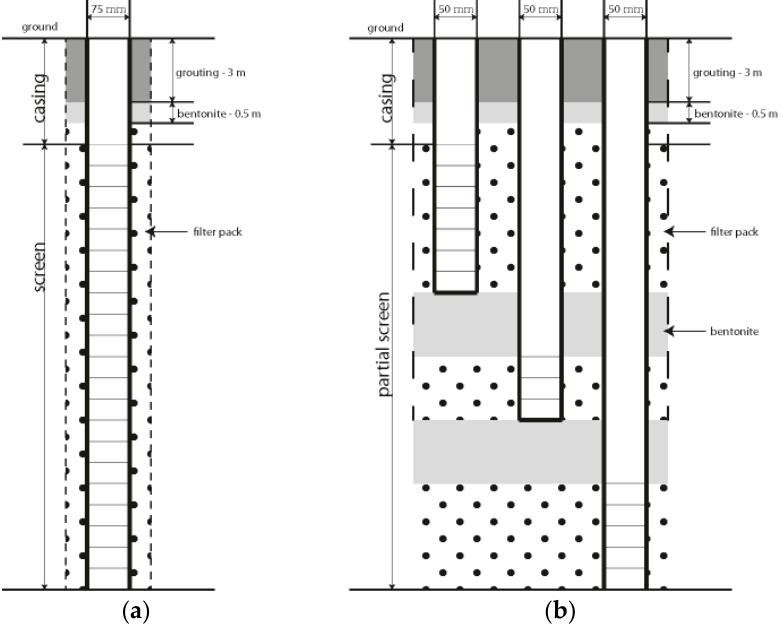
Figure 4. Design of observation wells; ( a ) single well and ( b ) multi-well.